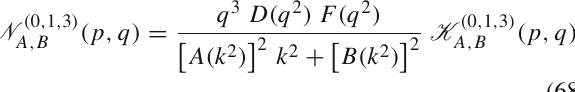
Fig. 7 The scalar (top) N ( 1 ) ( p , q )/ p 2 kernel components of the Dyson–Schwinger equations. N ( 1 ) A See also the caption of Fig.